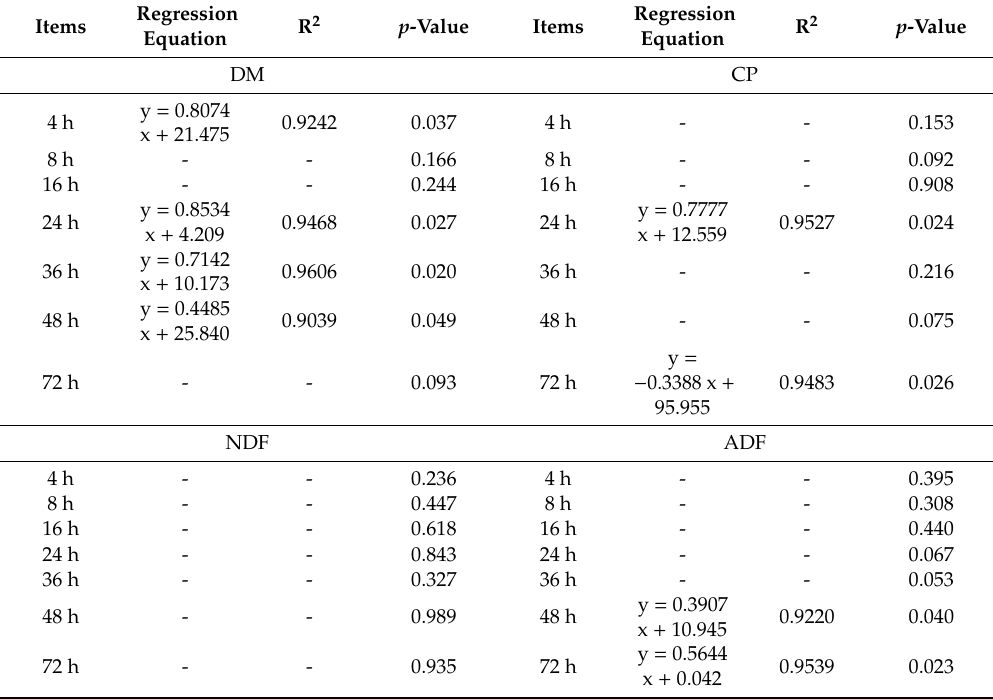
Table 6. Correlation of amaranth silage between e ff ective degradability and ruminal degradability of DM, CP, NDF, and ADF at di ff erent time